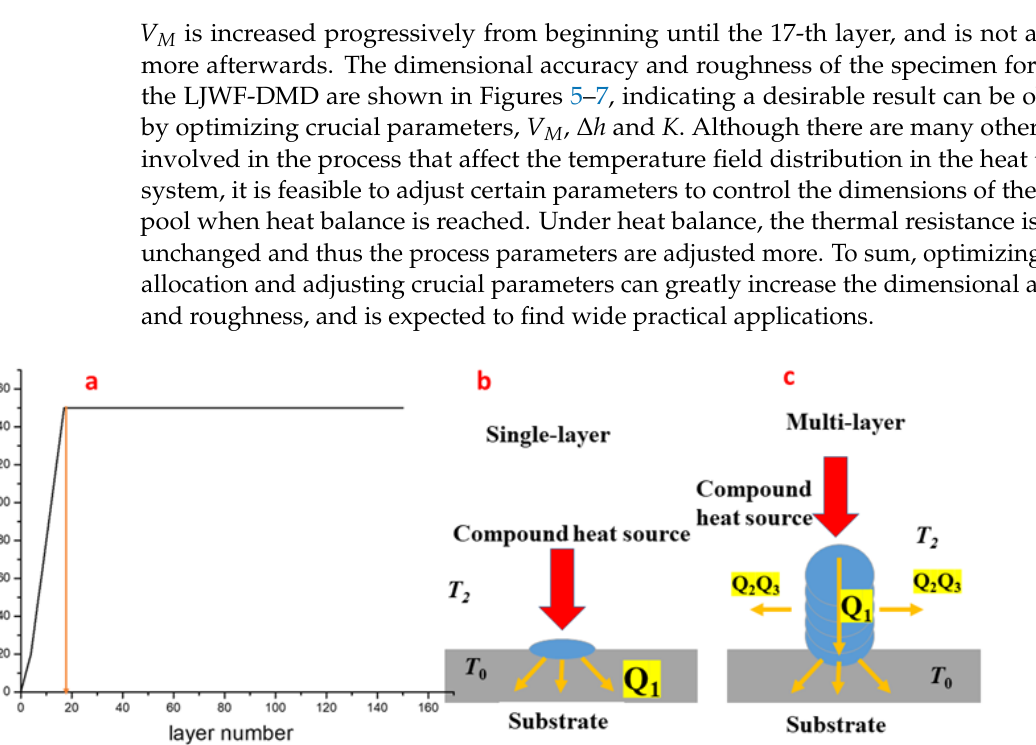
Figure 11. ( a ) Relationship between the moving speed at each layer of the thin-walled part. ( b ) Heat dissipation of the 1-st layer. ( c ) Heat dissipation of several layers.